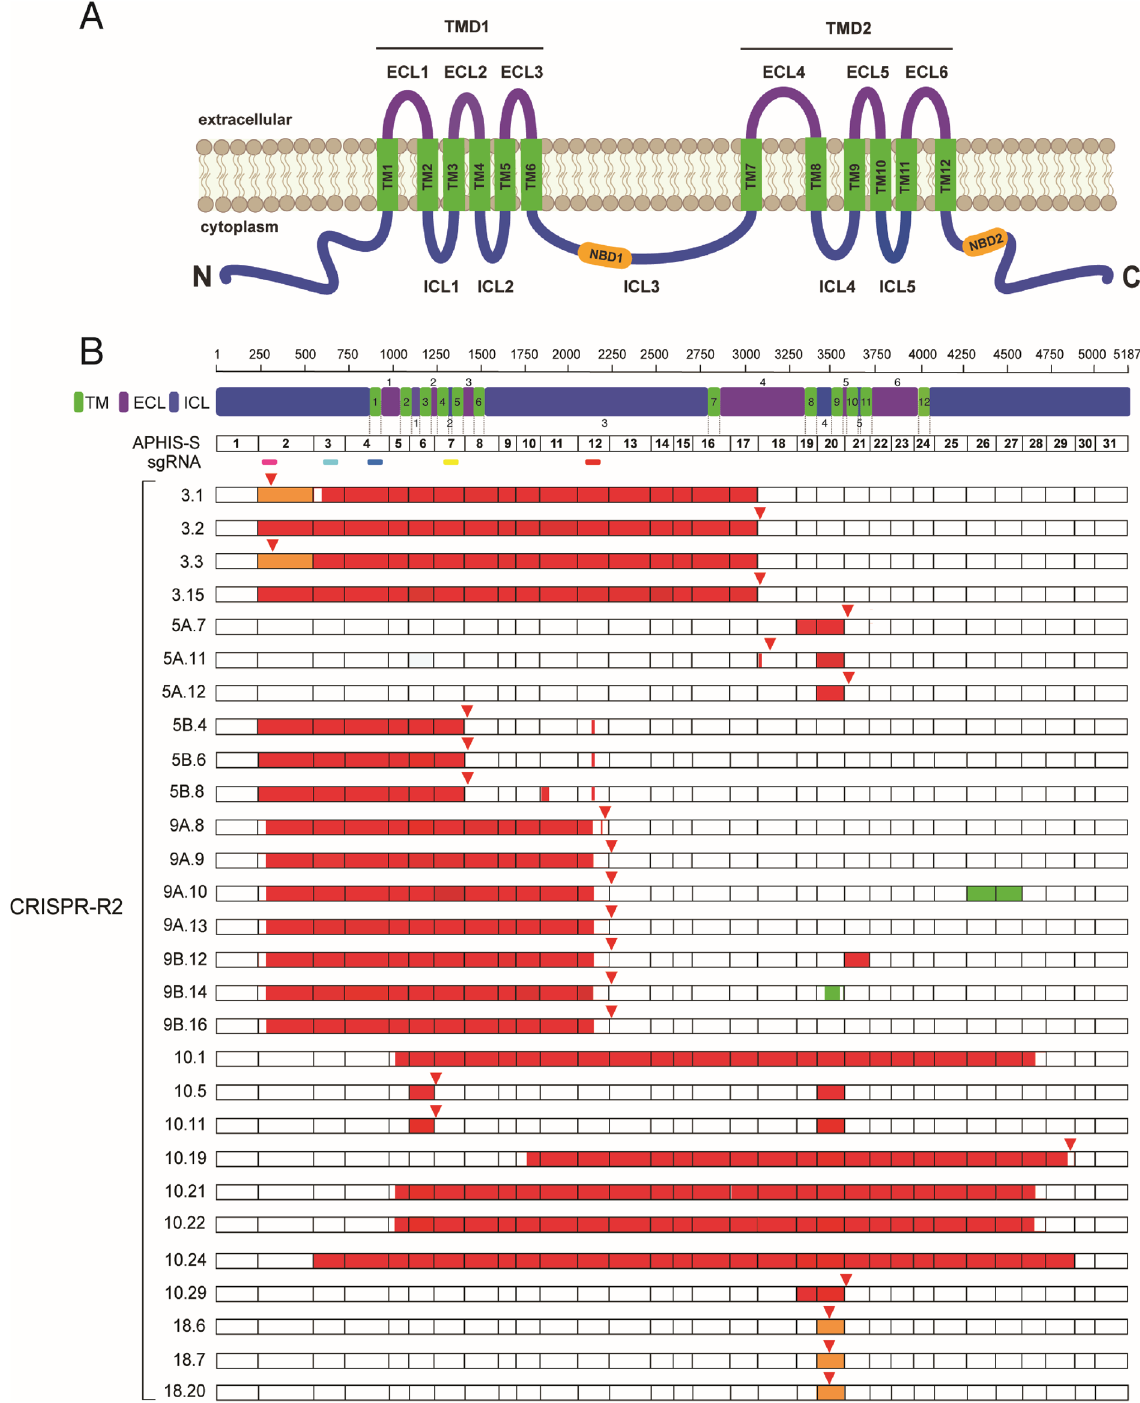
Figure 1. Mutations in 28 PgABCA2 cDNA sequences from five Cry2Ab-resistant pink bollworm larvae from the CRISPR-R2 strain that lacked gDNA mutations in sgRNA target sites. ( A ) The predicted PgABCA2 protein includes amino (N) and carboxyl (C) termini and transmembrane domains (TMD1 and TMD2). Each TMD contains six transmembrane-spanning regions (TM, green), three extracellular loops (ECL, purple), and two intracellular loops (ICL, blue). The two TMDs are connected by a single intracellular loop (ICL3). ICL3 and the C-terminal domain each contain a nucleotide-binding domain (NBD, orange). ( B ) Mutations in PgABCA2 cDNAs from CRISPR-R2 (3–8 clones from each of five individuals: 3, 5, 9, 10 and 18) relative to the susceptible strain APHIS-S (MG637361). Individuals with two distinct PCR products cloned are indicated as A or B (e.g., 5A and 5B, etc.). Numbers to the right of the decimal point for each individual indicate the clone sequenced. Exon numbers are shown for APHIS-S. Location of sgRNAs 1–5 are shown as colored bars (sgRNA1, magenta; sgRNA2, cyan; sgRNA3, blue; sgRNA4, yellow; sgRNA5, red). Red triangles above bars indicate premature stop codons, which occur in all sequences except 10.1, 10.21, 10.22, and 10.24. Colors within bars show mutations: orange for insertions and deletions (indels), red for deletions, and green for